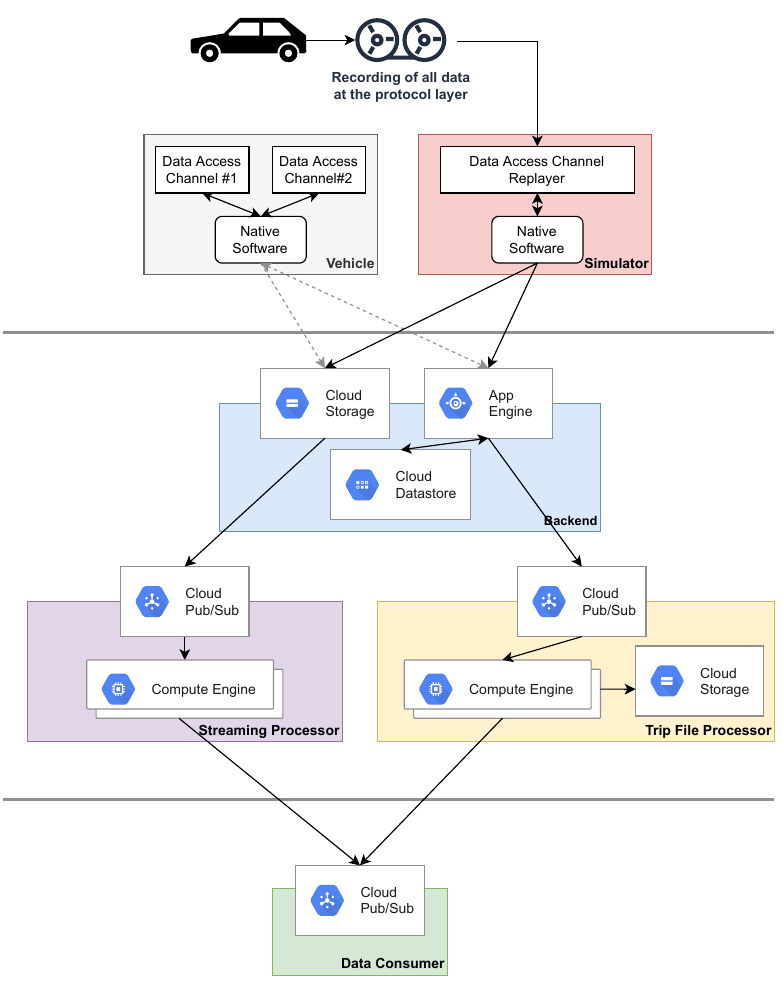
Figure 10. Setup of the performance evaluation: Using our simulators, we generate the same load as regular vehicles. The load is processed by three different infrastructures, for which we perform separate